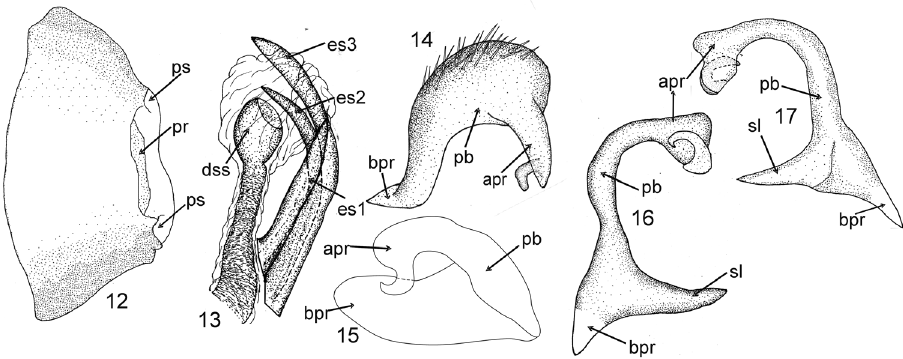
Figure 12–17. Male genitalia of Sulawesifulvius thailandicus . 12 Genital capsule (dorsal view, aedeagus and parameres removed) 13 Endosoma (right lateral view) 14 Right paramere (right lateral view) 15 Right paramere (dorsal view) 16 Left paramere (right lateral view) 17 Left paramere (let lateral view). Abbrevia- tions: apr = apical process; bpr = basal process; dss = sclerotized portion of ductus seminis inside endosoma; es 1, 2, 3 – endosomal sclerites; pb = paramere body; pr = proctiger; ps = paramere socket; sl = sensory